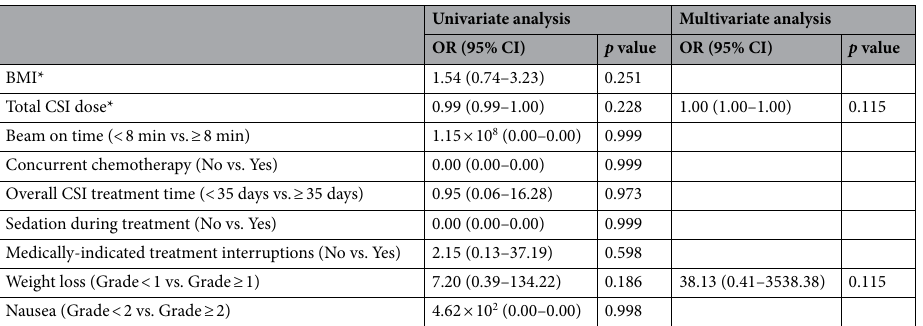
Table 4. Risk factors for significant intrafractional movement in adult patients. OR odds ratio; CI confidence interval; BMI body-mass index; CSI craniospinal irradiation. *BMI and total CSI dose was treated as a continuous variable. The foreparts of the parentheses were set as the reference groups in the multivariable